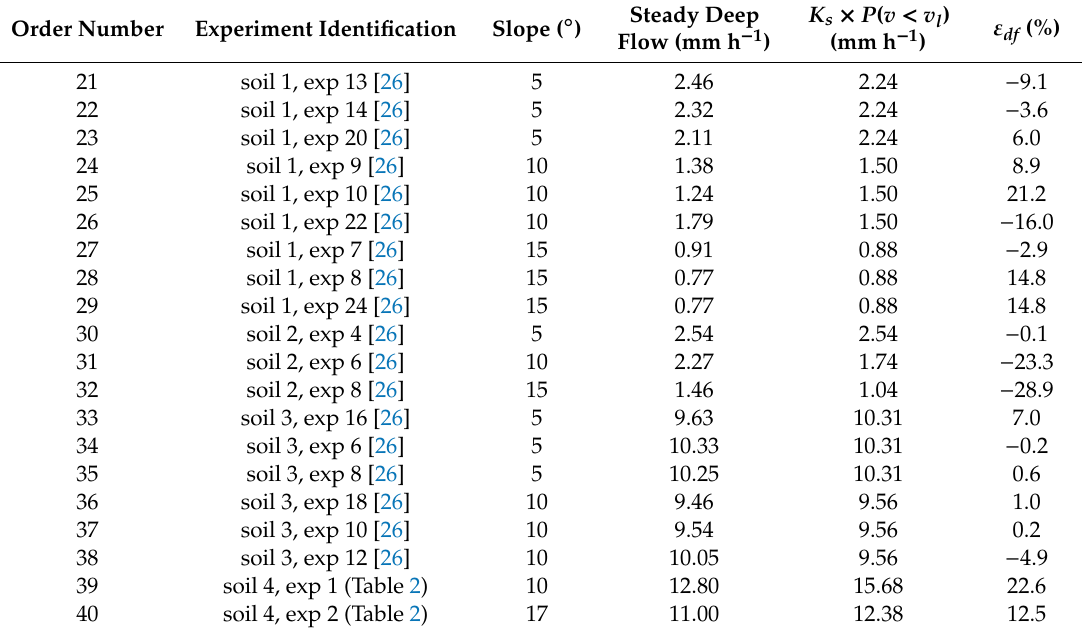
Figure 7. The λ parameter of Equation (4) obtained for the calibration experiments performed at the different slope angles. The best interpolating function is also plotted. Table 4. Model validation synthesized through the relative error of the steady deep flow, ε df (Equations (6) and (7)).